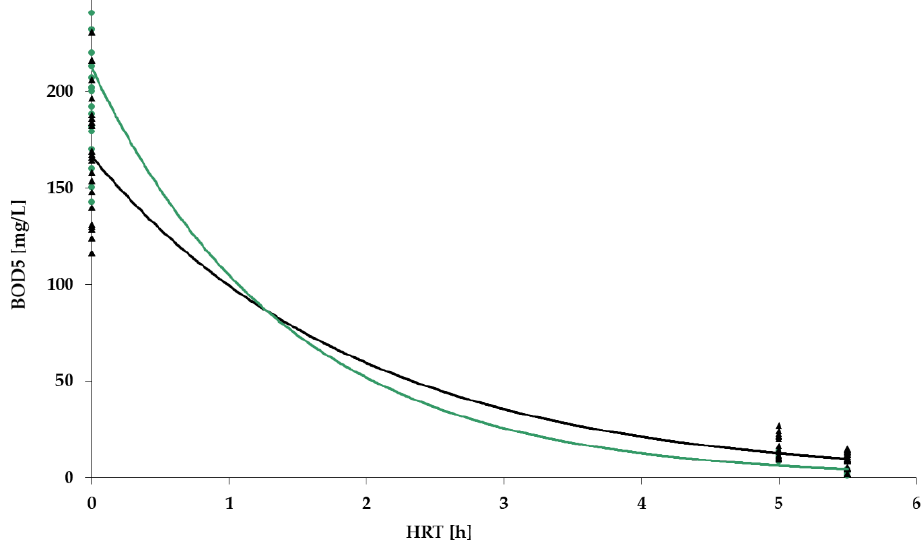
Figure 14. BOD 5 removal dynamics for PV floating carrier: stage 1 (black); stage 2 (green).